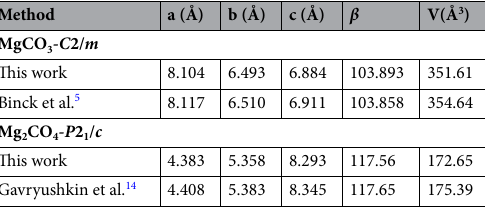
Table 1. Lattice parameters of MgCO 3 - C 2/ m and Mg 2 CO 4 - P 2 1 / c at 110 GPa and 100 GPa, respectively, compared with experimental and previous